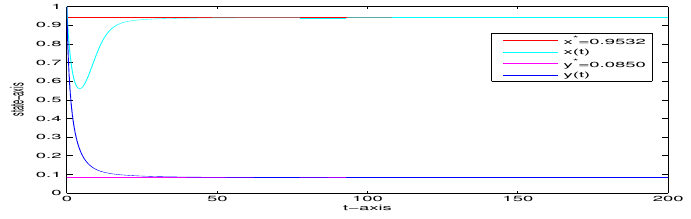
Figure 4. Global stability of E ∗ ( x ∗ , y ∗ ) of Model (2) with τ 1 = τ 2 = 0.2.